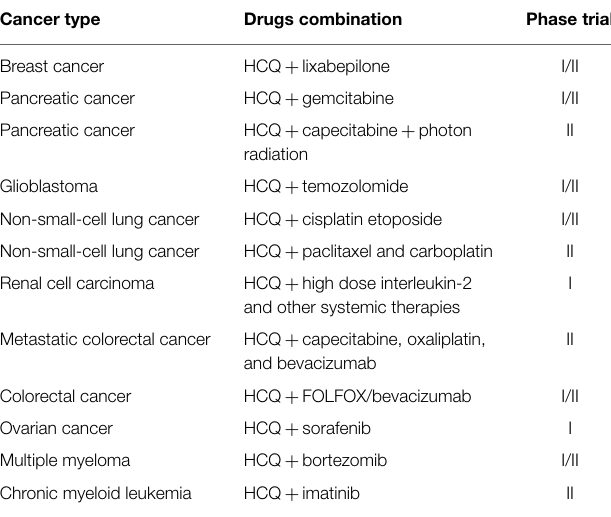
TABLE3 | SomeoftheclinicaltrialscombiningtheautophagyinhibitorHCQ . Cancer